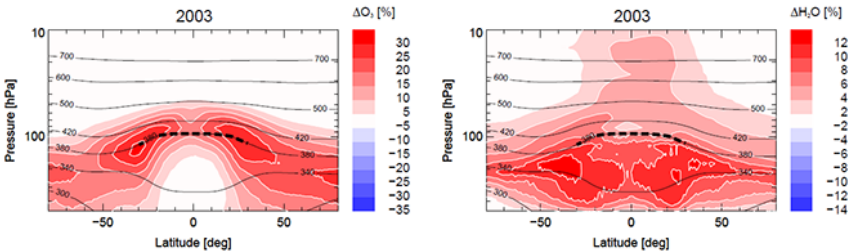
Figure 2. Influence of uncertainties in the atmospheric mixing strength on simulated UTLS ozone (left) and water vapour (right). Shown are percentage differences for zonally averaged values (2003) obtained for two simulations with the Chemical Lagrangian Model of the Stratosphere (CLaMS), spanning the current uncertainty range of atmospheric mixing strength. For details see Riese et al. (2012).